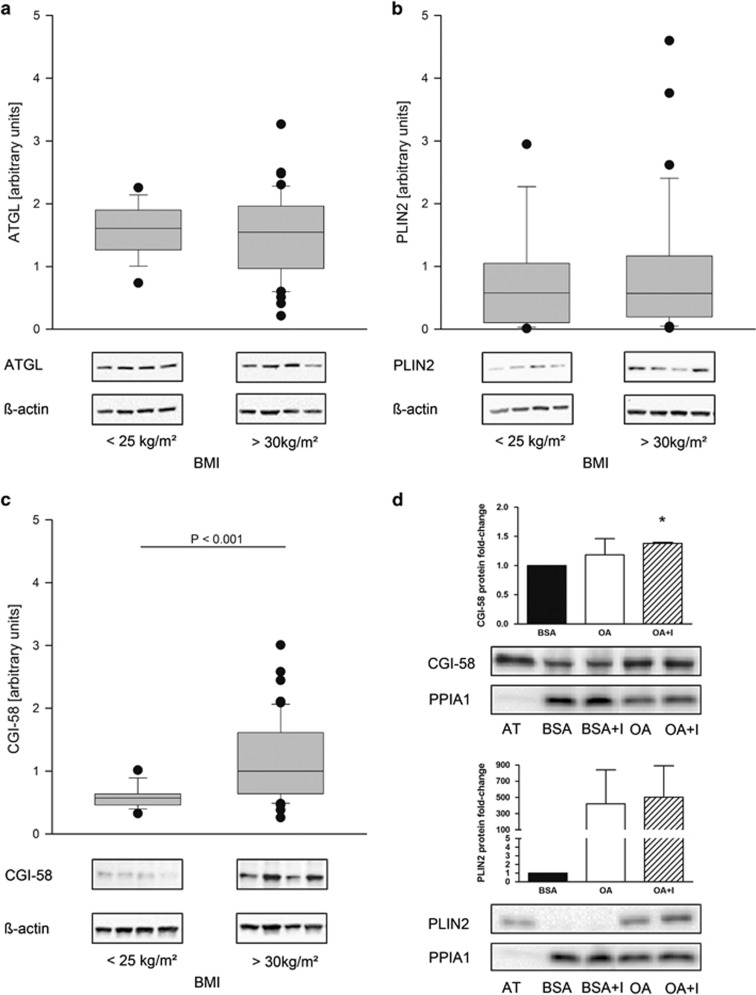
Placental CGI-58 is regulated by maternal pre-pregnancy obesity. Lower panel: representative western blots (n=4 per group) of total placental tissue. (a) ATGL protein expression. (b) PLIN2 protein expression. (c) CGI-58 protein expression. All protein signals were quantitated by densitometry, normalized to β-actin as loading control and to one protein sample which was used on each blot to correct for inter blot variations. Sum rank test was performed, differences between the lean (BMI<25 kg m−2, n=18) and obese (BMI>30 kg m−2; n=45) group were defined as significant if P-values were <0.05. (d) Isolated primary trophoblast cells were treated for 24 h with oleic acid (OA, 80 μmol l−1), oleic acid and insulin (OA+I, 10nmol l−1). Bovine serum albumin (BSA) or BSA and insulin (BSA+I) was used in identical concentrations. Adipose tissue (AT, 2 μg) served as positive control. The upper panel indicates semi-quantitative analysis, signals for BSA were set to 1 and signals for OA and OA+I are presented relative to the BSA control. *P<0.05 indicate statistical significant difference to BSA control. In the lower panel, one representative experiment out of three independent trophoblast isolations is shown.